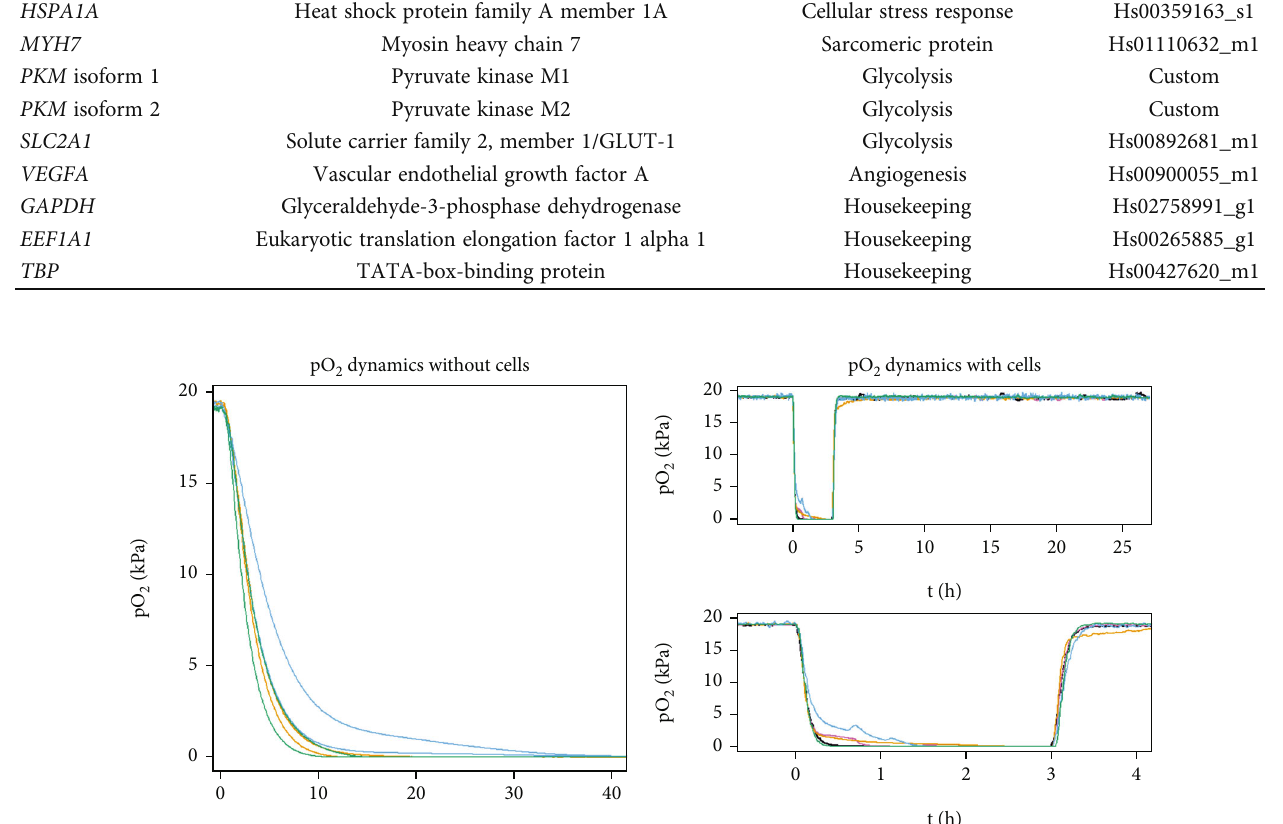
) in 1-well assembly with and without the hiPSC-CMs. (a) Oxygen partial 2 without cells ( n = 6 ). The mean fall time (from 90% to 10%) was 6 : 35 ± 2 : 55 min . (b) 2 with cells on MEA ( n = 5 ). The mean fall time was 18 : 97 ± 15 : 86 min 2